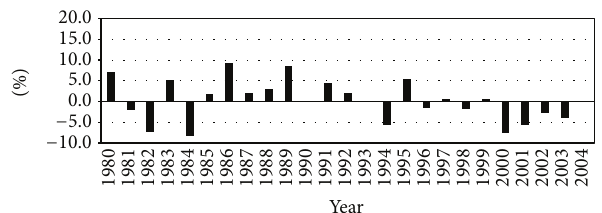
Figure 12: The deviation rate of simulated ET compared to measured ET.